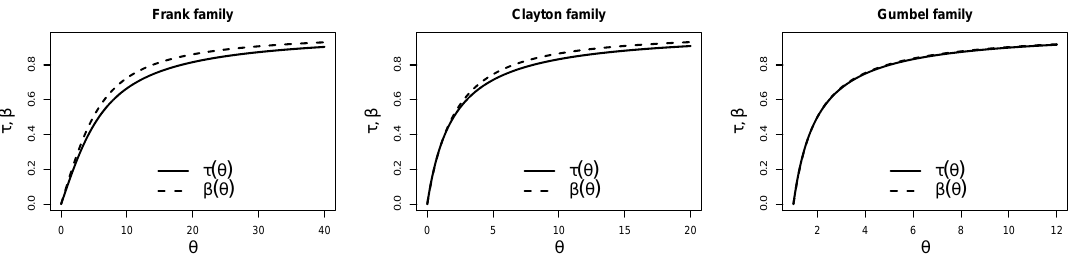
Figure 5: Comparison of Kendall’s tau and Blomqvist’s beta as functions of the copula family parameter θ for different copula families.